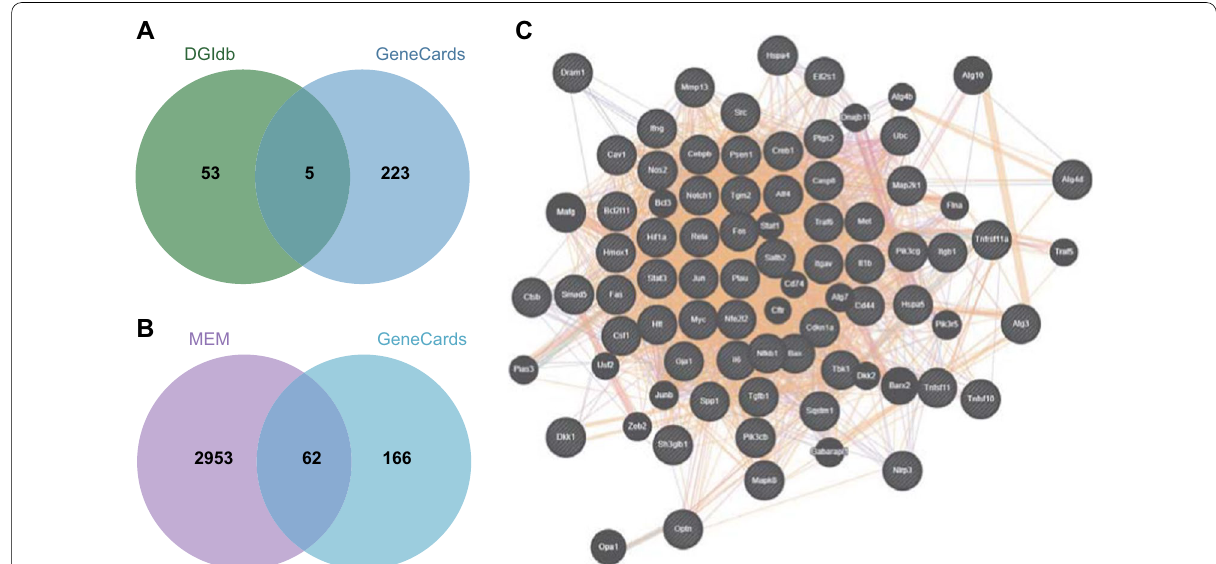
Fig. 1 Bioinformatics analysis suggests a TNF-α/SATB2 axis in osteoblast autophagy. A Venn diagram of Risperidone-interacted genes obtained from the DGIdb database and osteoblast autophagy-associated genes from the GeneCards database. B Venn diagram of genes related to TNF-α from the MEM database and osteoblast autophagy-associated genes. C co-expression network of candidate genes in panel